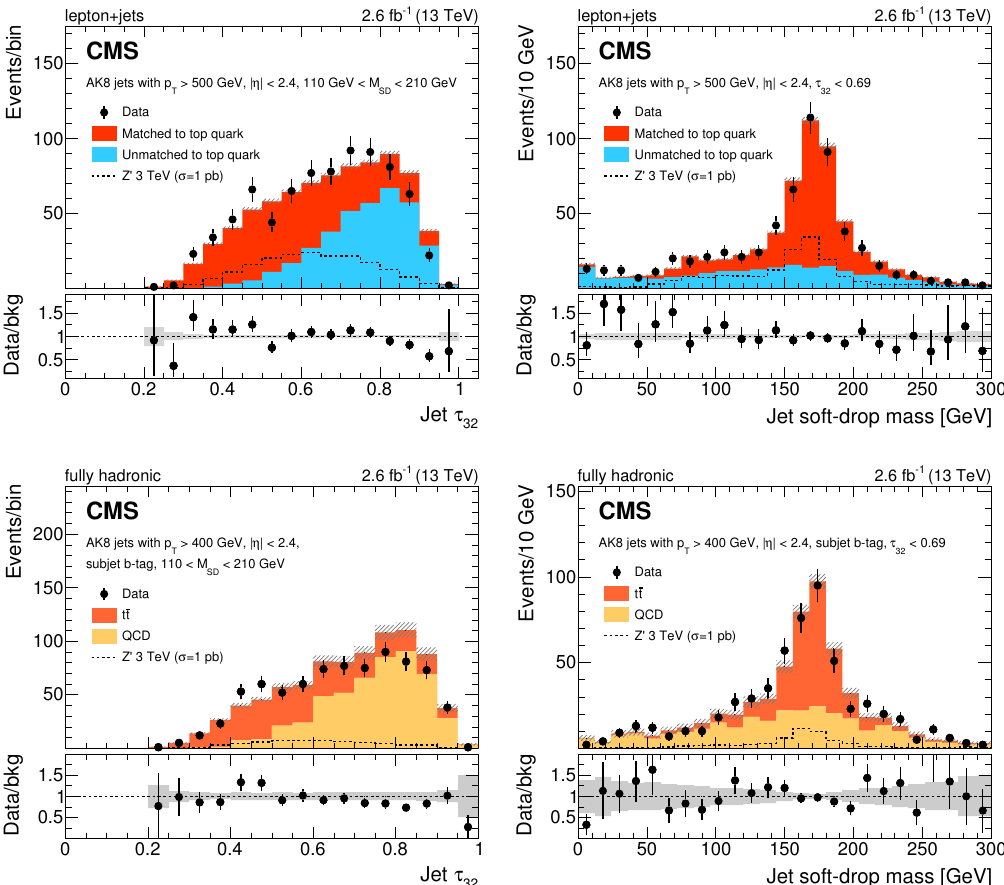
Figure 2 . Distributions of the N-subjettiness ratio, (cid:28) 32 , and the soft dropped mass, M SD , for AK8 jets in data and simulation, after the signal selection. For lepton+jets, with p T > 500 GeV (upper row). For the fully hadronic (cid:12)nal state, with p T > 400 GeV and subjet b tag (lower row). The distribution of (cid:28) 32 (left) is shown after the selection 110 < M SD < 210 GeV, and the distribution of M SD (right) is shown after the selection (cid:28) 32 < 0 : 69. The lepton+jets channel plots compare data to background simulation, where the latter is divided into contributions from jets matched at the generator level to top quarks and other jets in top pair or W+jets events. The fully hadronic channel plots compare data to tt and QCD multijet simulation. Contributions from a benchmark narrow Z 0 signal model are shown with the black dashed lines. In obtaining the (cid:12)nal results, NTMJ production is estimated from data, and simulated QCD multijet events are not used. In all plots, the error bars include only statistical